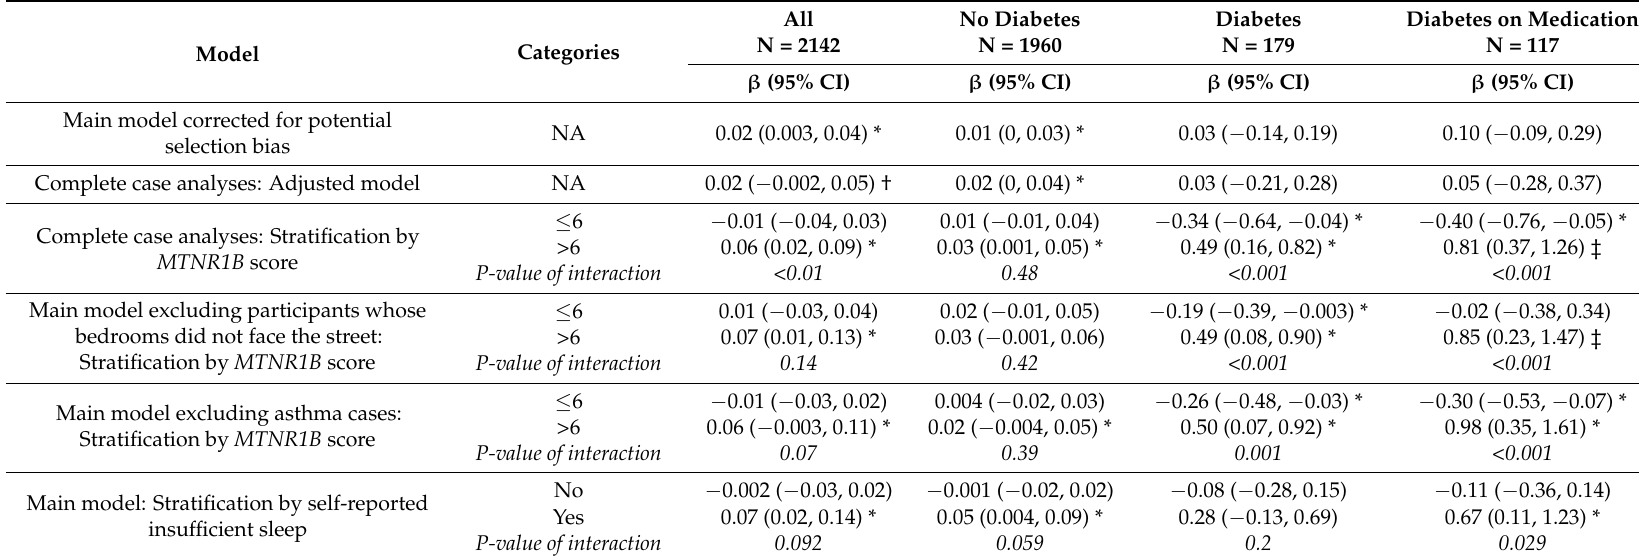
Table 4. Sensitivity analyses on the association between night-time road traffic noise and change in HbA1c, in non-movers.